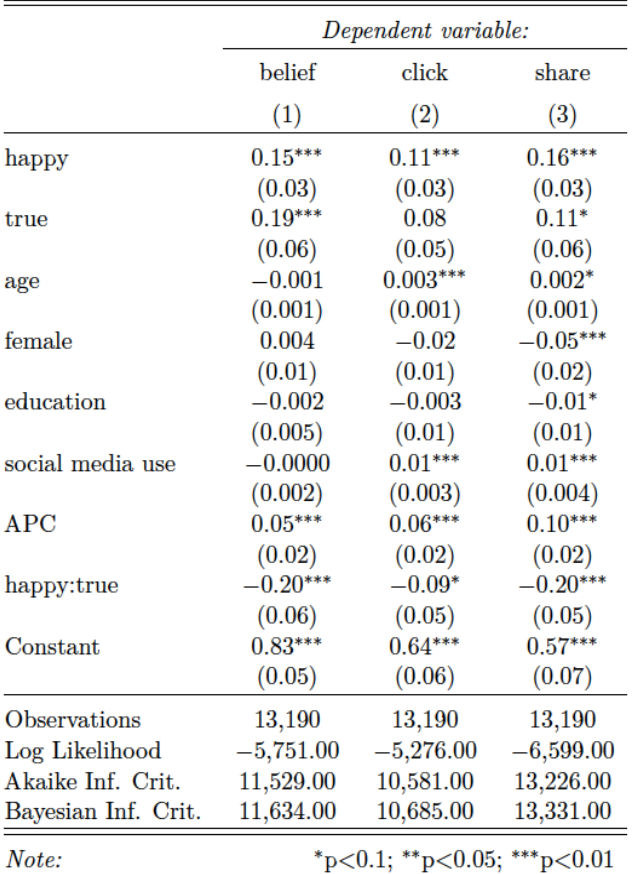
Table C4. Predicting outcomes with controls: